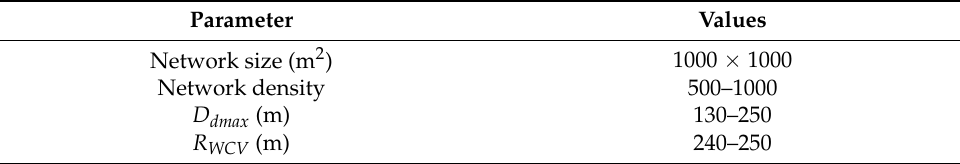
Table 3. Simulation parameters of the deployment